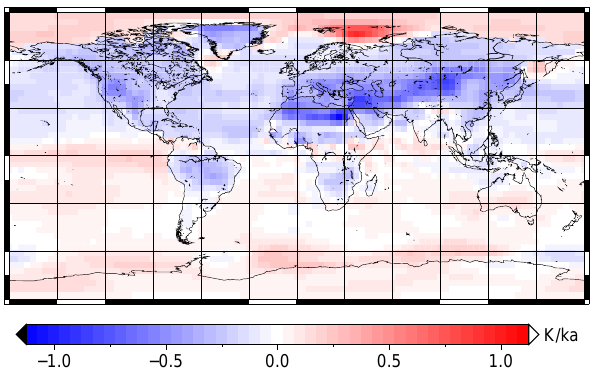
Fig. 3. Linear trend in annual mean surface temperature over the simulation period in K/ka - Kelvin per 1,000 years